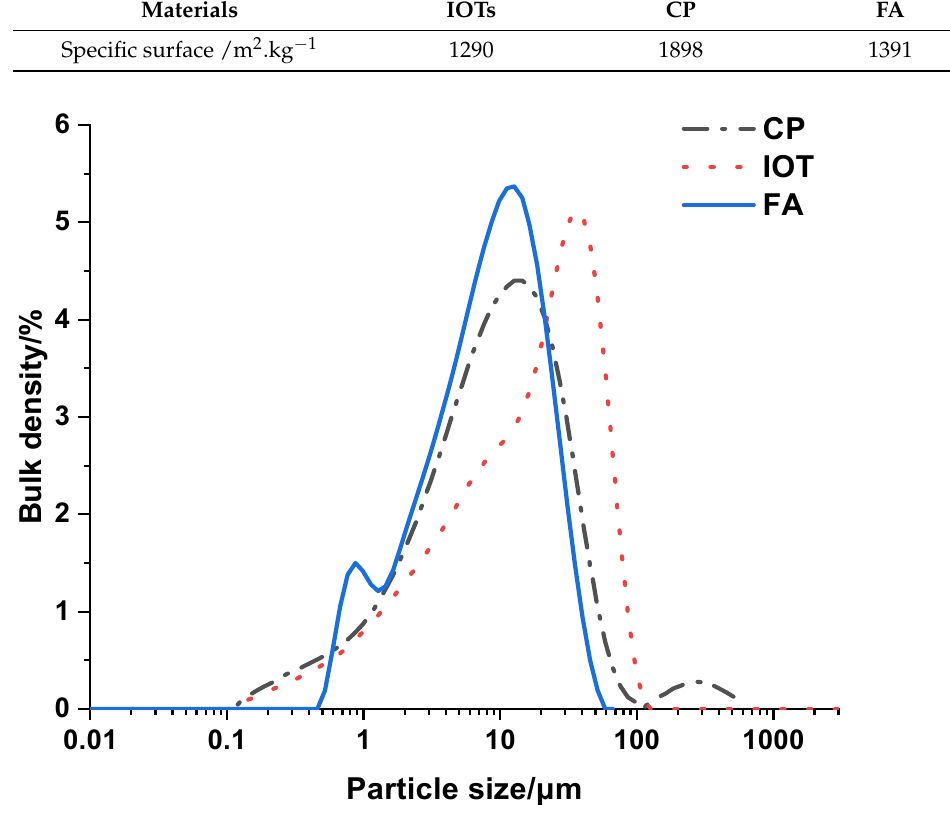
Figure 2. Particle size distribution of IOTs, CP and FA.